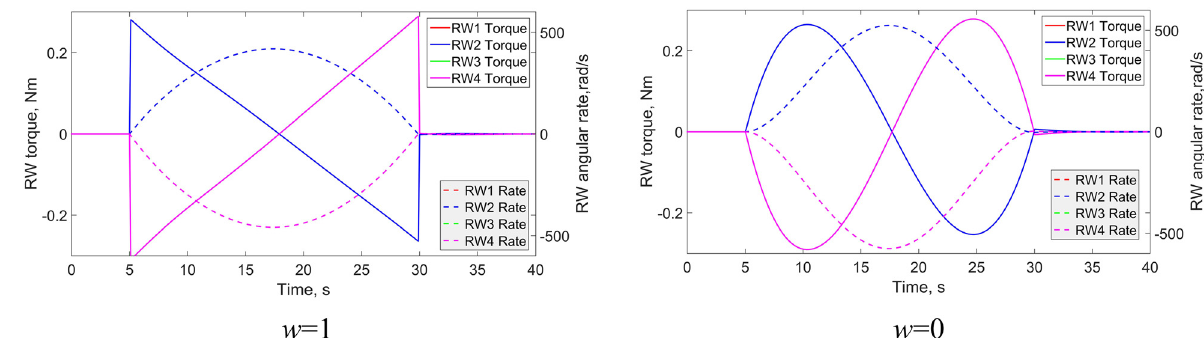
Figure 18: RW control torques and angular velocities for case